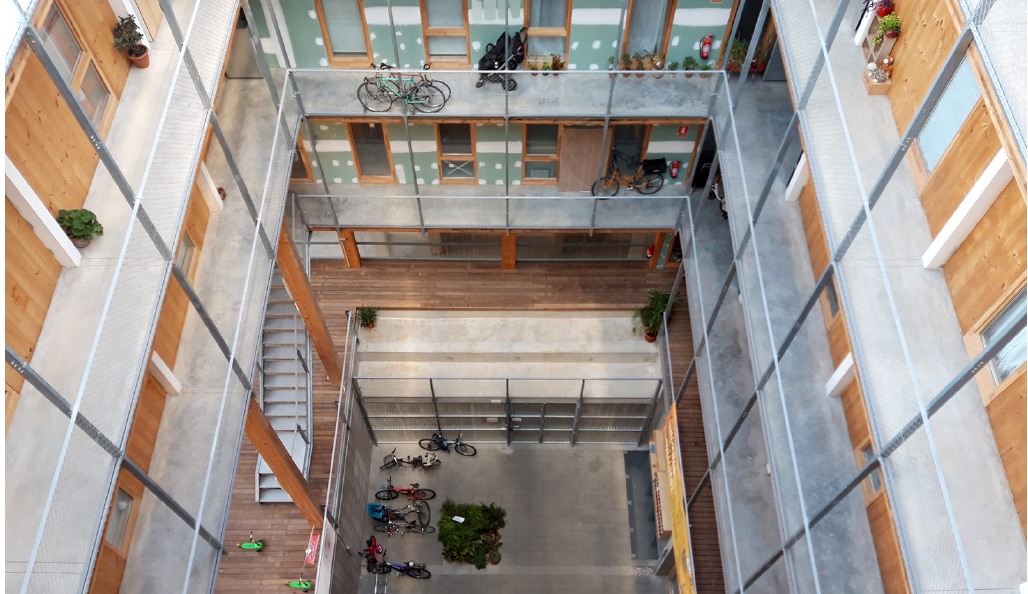
Figure 8. La Borda , Barcelona, 2018, by LaCol Architectura Cooperativa. The image (taken two months after the residents moved into the building) shows the unfinished state of the building, understood as a constant process. Source: